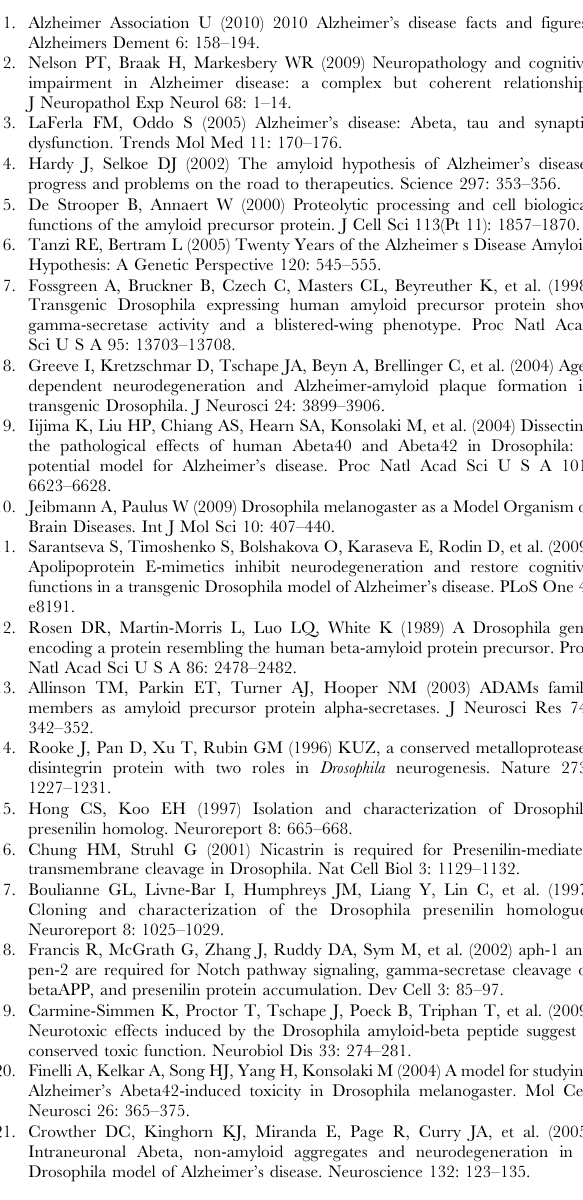
Figure S4 Motor reflex behavior. A ) Expression of human APP alone does not change motor reflex behavior, as measured by the climbing assay. Parental strains listed. Error bars show standard error. No significant difference exists between elav ; APP ; (ANOVA, p= .601 ) or in days 12–20 ( p= .677 ). B ) Expression